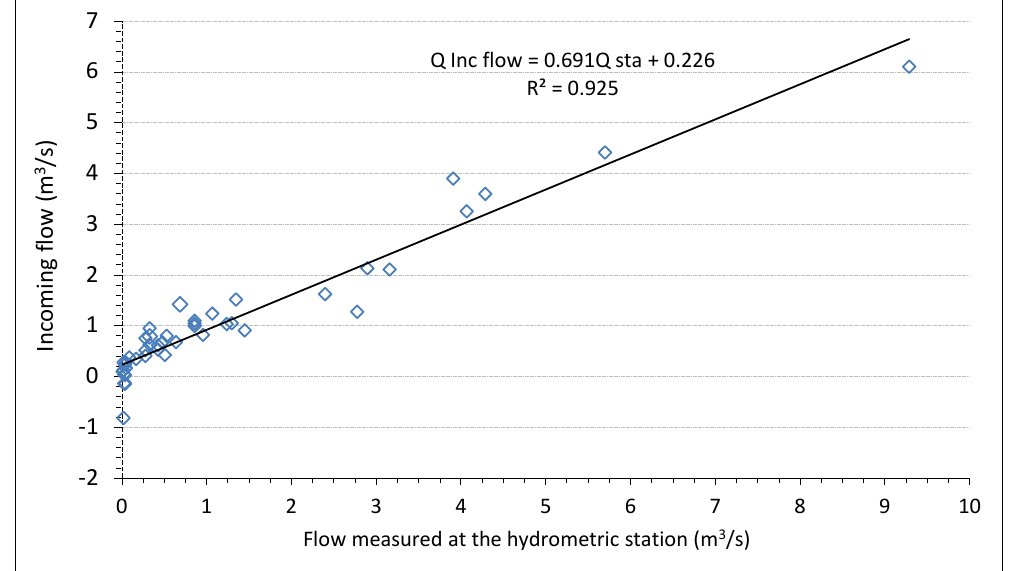
Figure 33. Variation of the real incoming flow in the bowl as a function of the flow recoded at the hydrometric station It should be noted that a percentage of 7.5 of the variance is not represented by this correlation, which proves that it is not only the flow of the tributary which passes through the hydrometric station which feeds the basin of the dam. Negative inflows have been observed, which indicates that there is a decrease in the level of the water level in the basin of the dam that is to say that the quantity of water leaving the basin exceeds that entering.